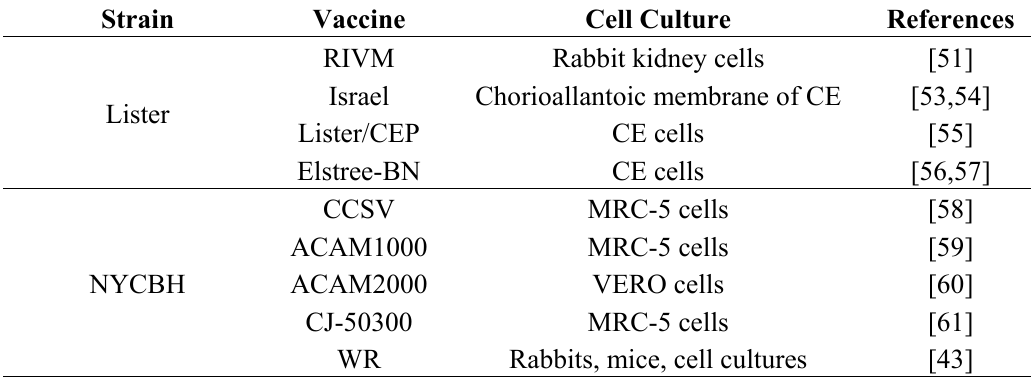
Table 2. List of the different second-generation VACV-based vaccines.